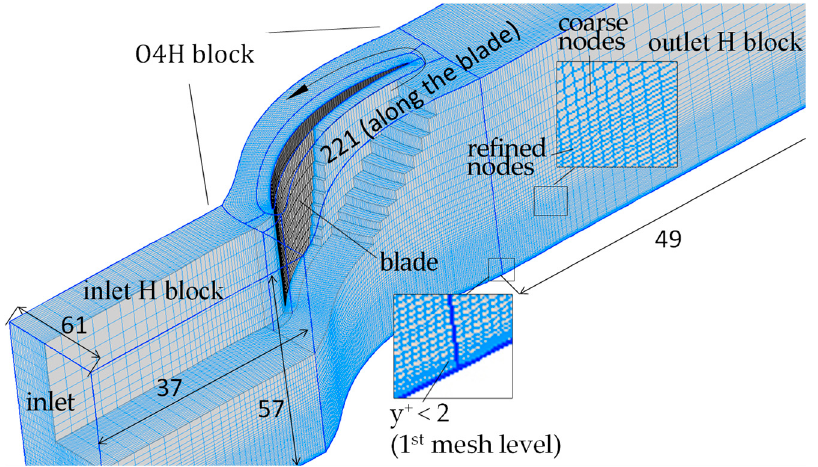
Figure 6. Overview of the computational mesh.